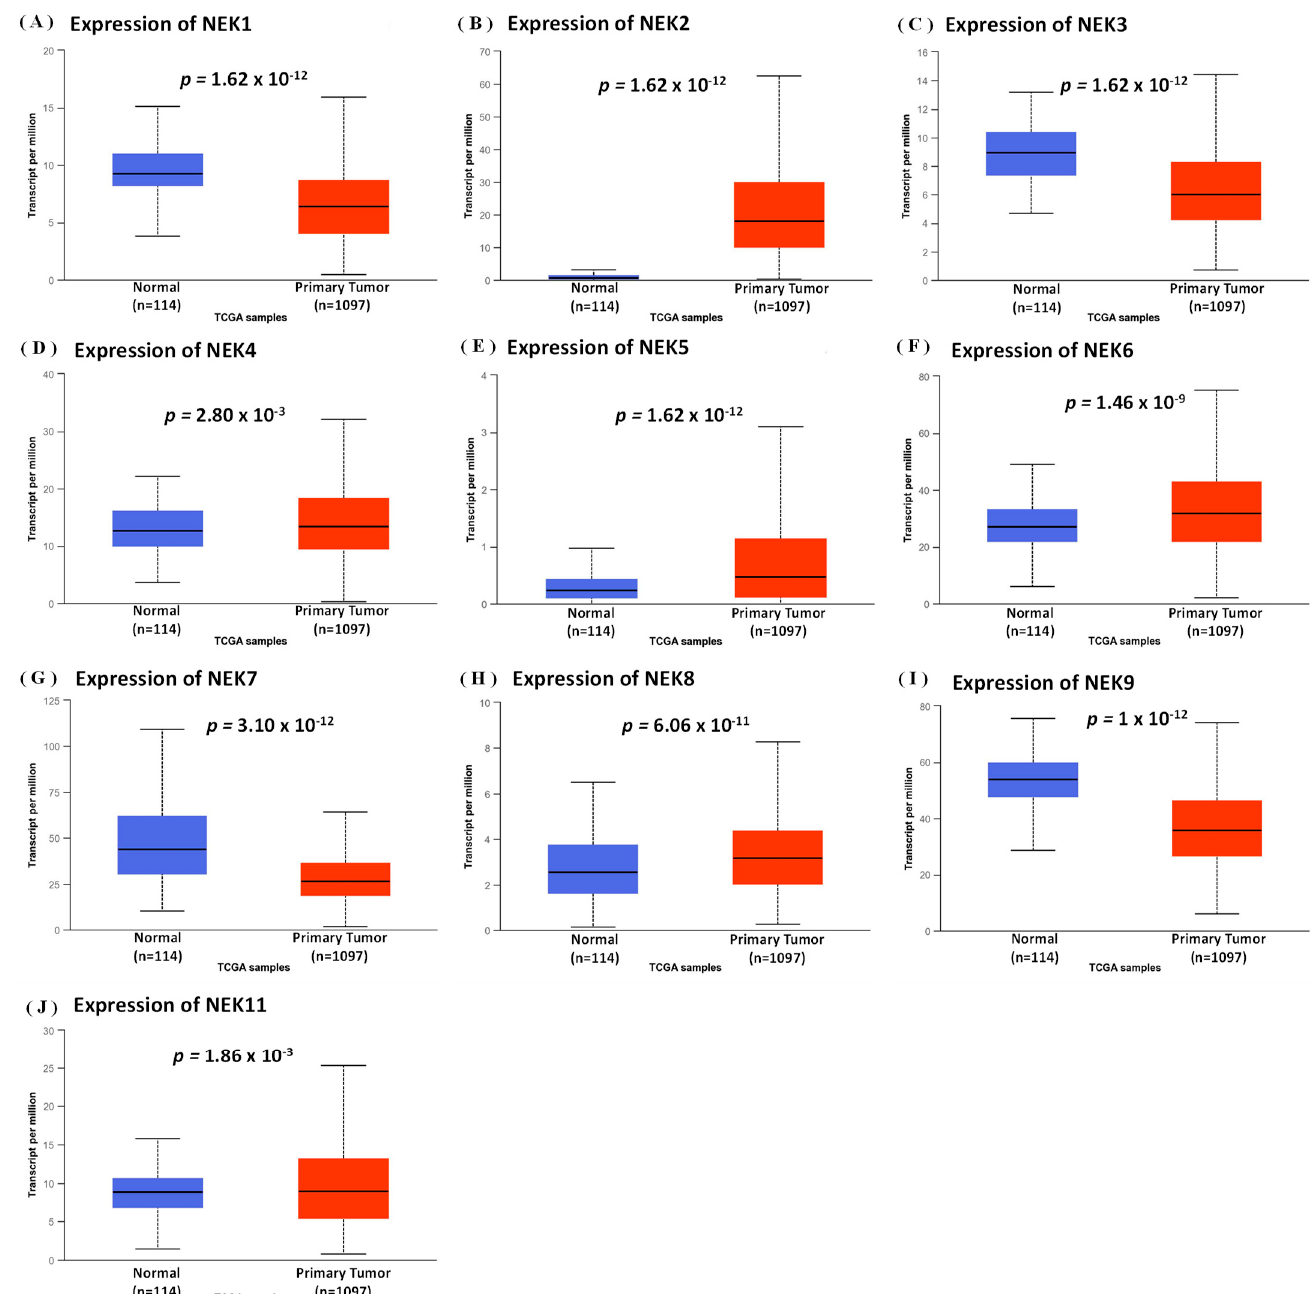
Figure 3. Expression of the NEK gene family in breast cancer (UALCAN Analysis). ( A – J ) Box plot of NEK gene family transcripts in normal and primary tumor (BRCA) tissues. The box plot shows comparisons of the expressions of TCGA data from the NEK gene family in breast cancer, between normal samples ( n = 114) and primary tumors ( n = 1097). Statistical significance is represented by p < 0.05.